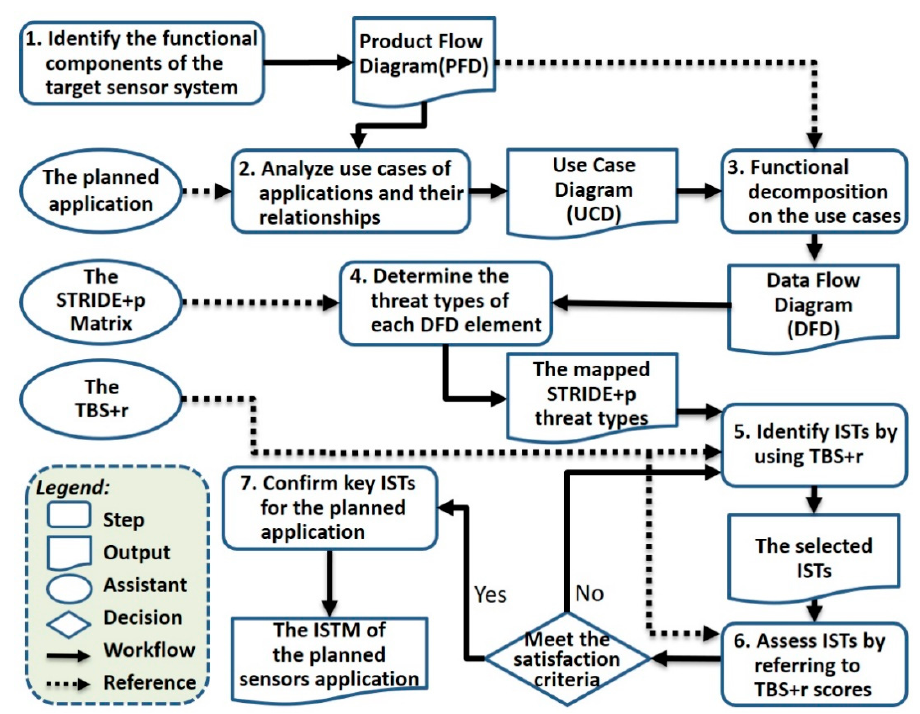
Figure 1. The proposed I-SERM process.